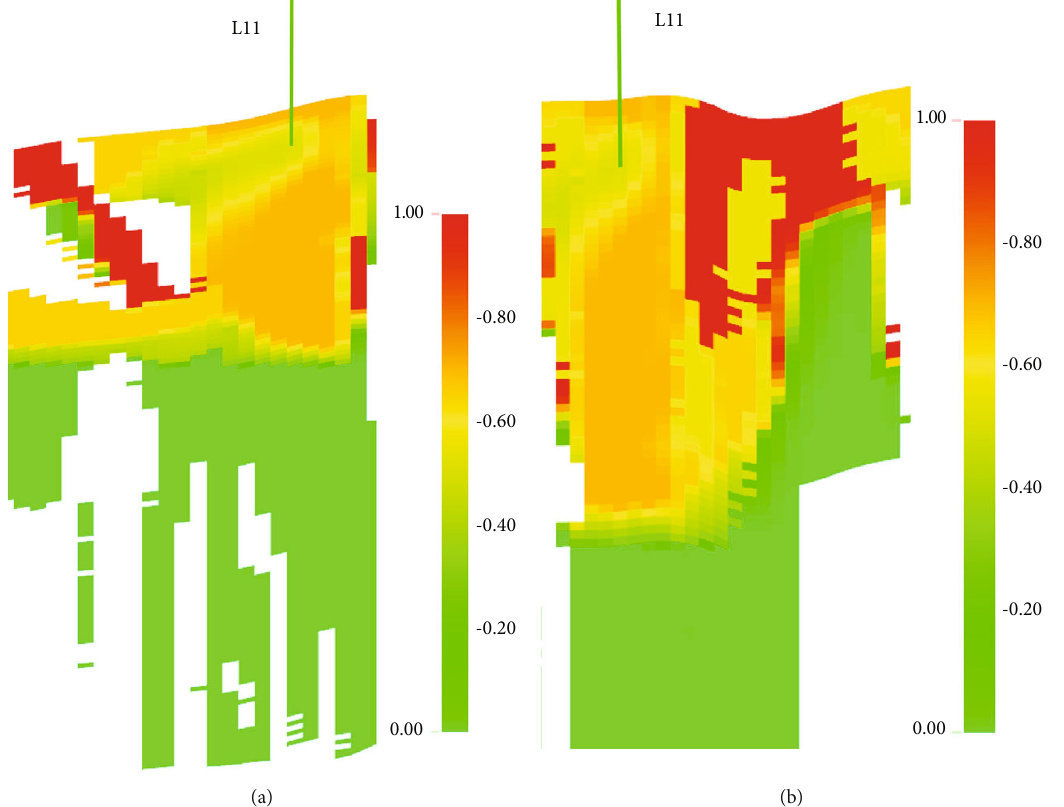
Figure 11: Distribution characteristics of residual oil in the L11